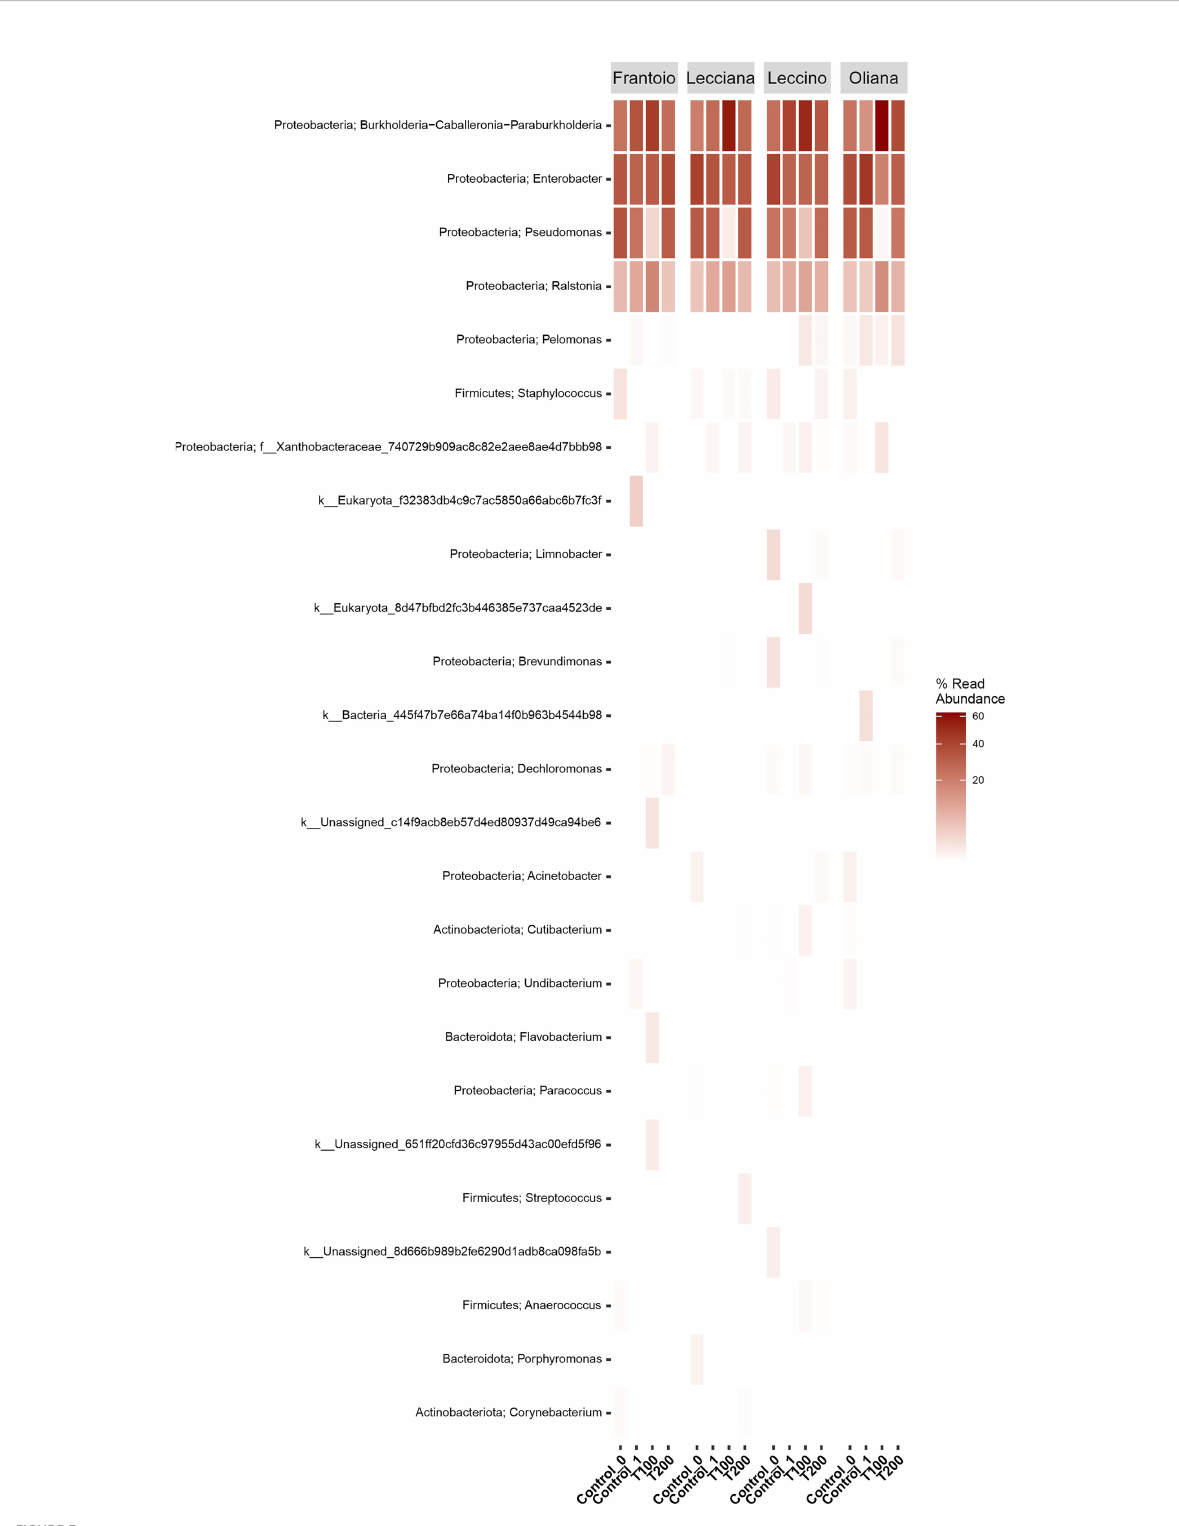
FIGURE 3 Heat-map of differentially abundant taxa. Data were computed at the genus level using the r package ampvis2. Data were grouped by cultivar and then were classi fi ed based on the percentage of read